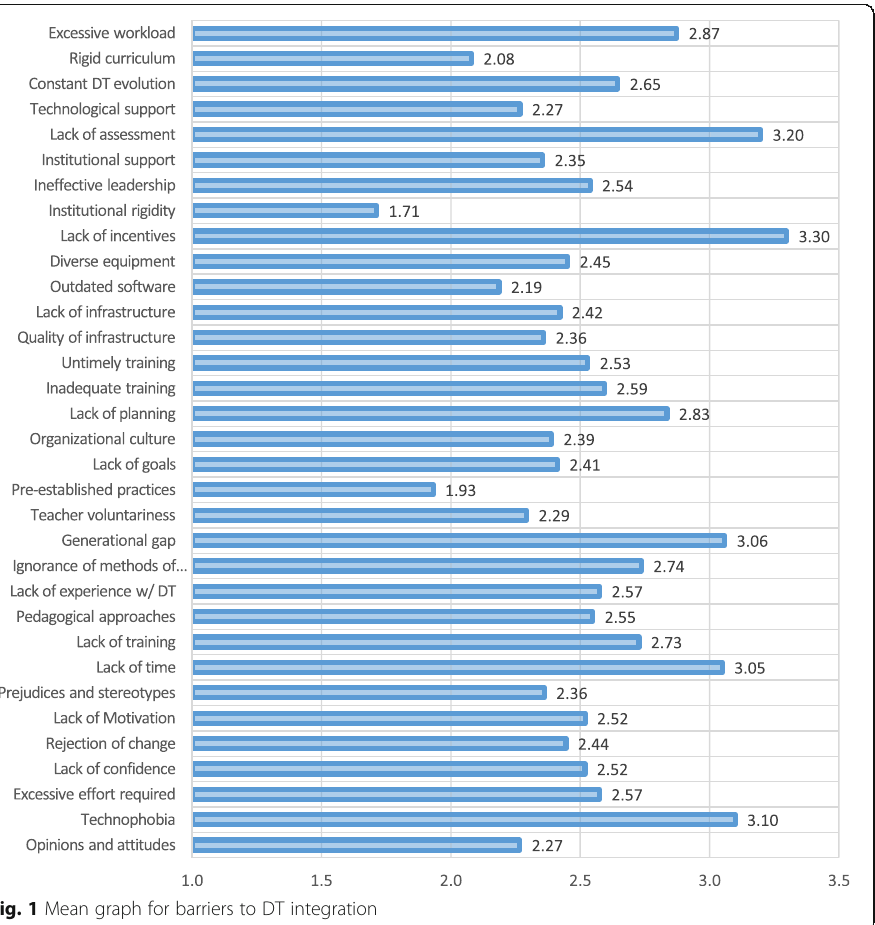
Fig. 1 Mean graph for barriers to DT integration